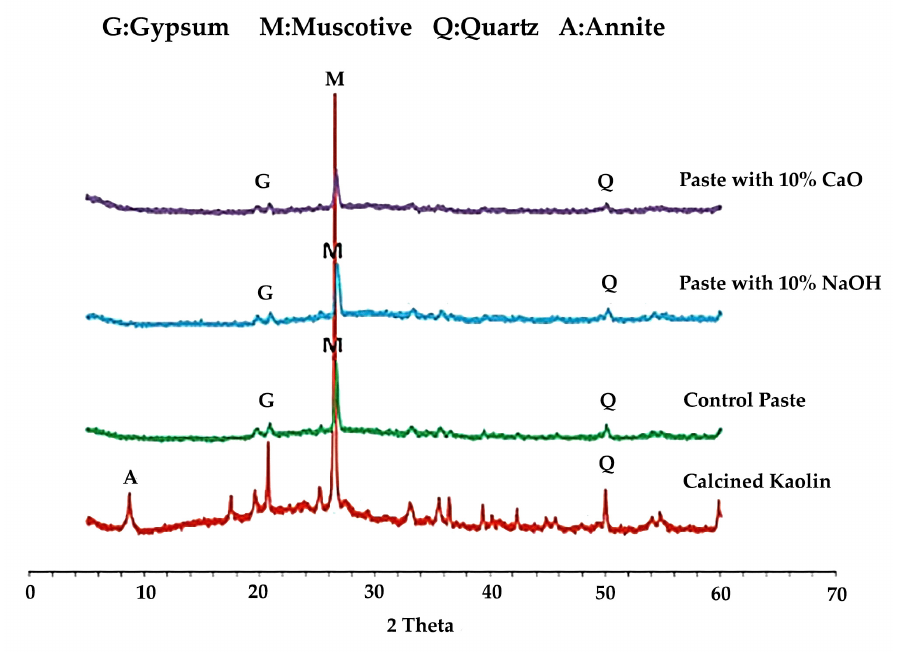
Figure 10. X-Ray Diffraction Analysis for kaolin-based geopolymer [79].